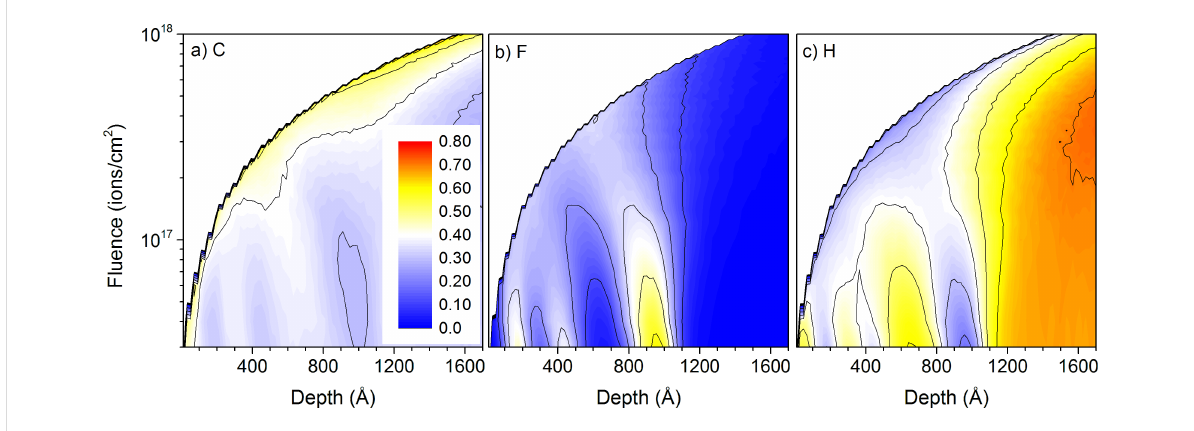
Figure 4: Sample composition as a function of depth and primary ion fluence for 20 keV Ne + irradiation of sample #4 with the thick-layer configura- tion: a) for carbon, b) for fluorine, and c) hydrogen. The colour scale shows concentrations from 0 to 80% and is identical for all species.